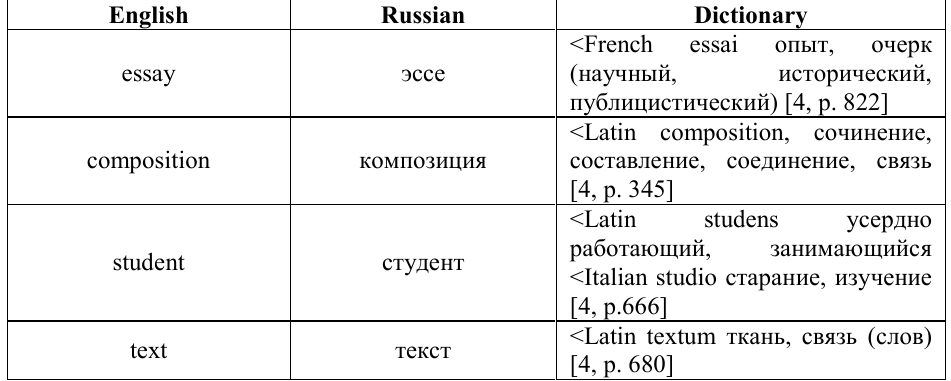
Table 1 – International words in the English and Russian